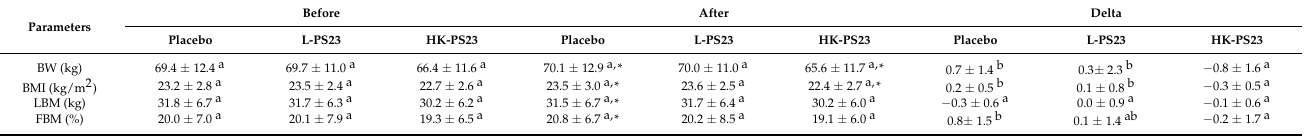
Table 3. Subject’s body composition before and after the 6-week L-PS23 and HK-PS23